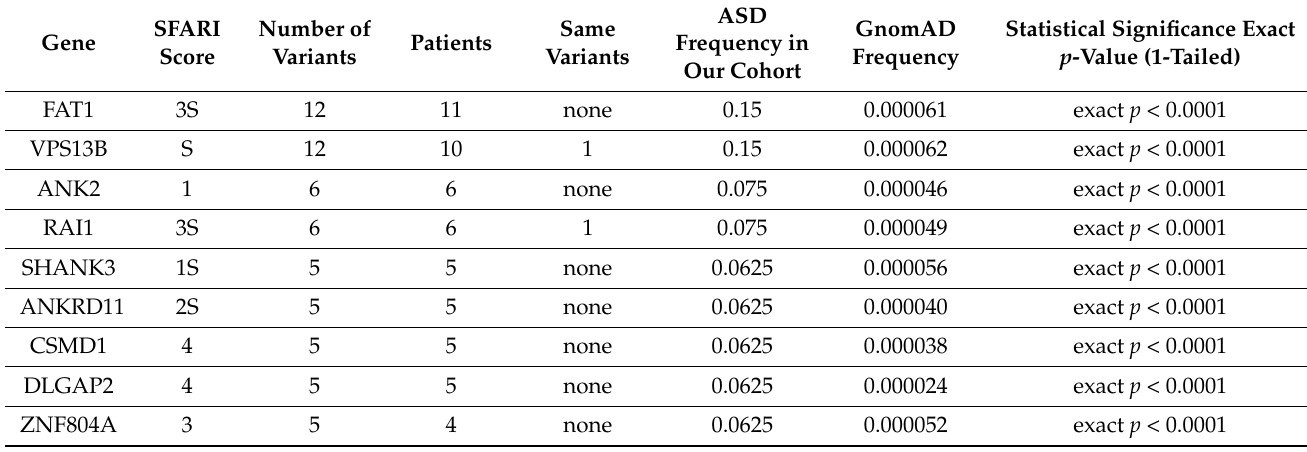
Table 3. Most frequently mutated genes in our